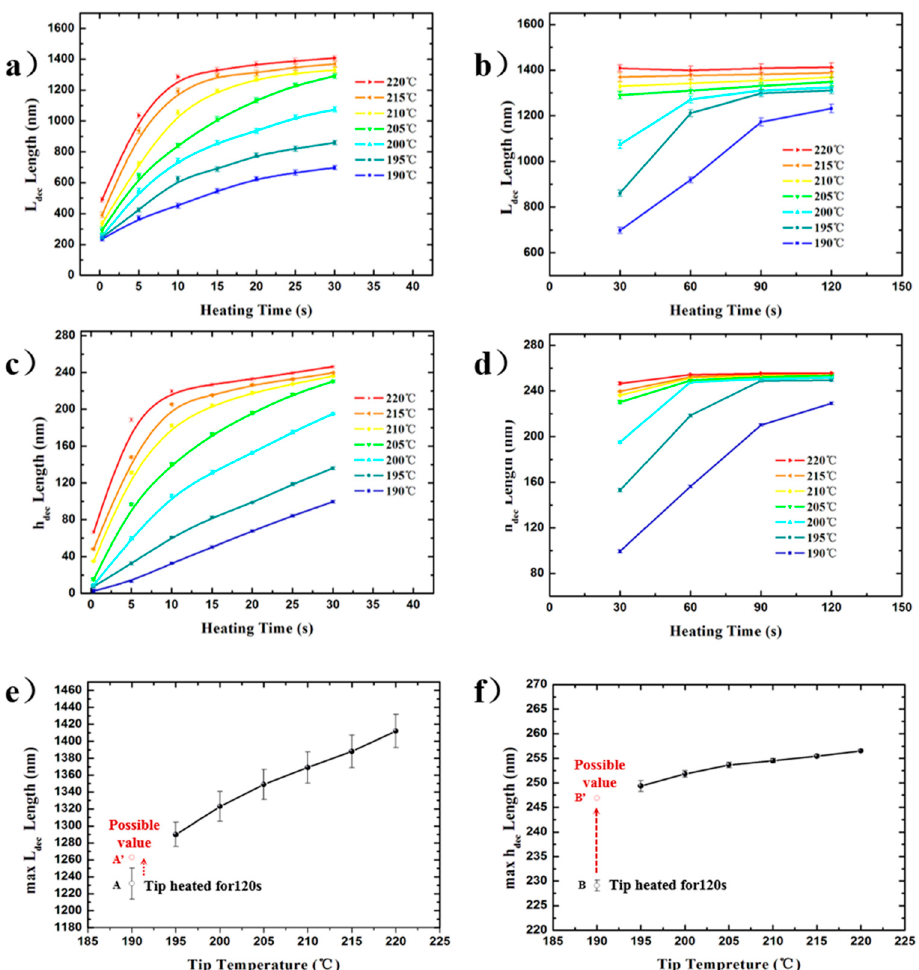
Figure 4. Function plot of the air gap feature sizes increasing with heating duration at the preset tip temperatures ( T t ) and the maximum feature sizes increasing with preset tip temperatures. ( a ) / ( b ) and ( c ) / ( d ) for L dec and h dec with 0.3–30 s / 30–120 s as the varying of heating duration, respectively, at T t of 190–220 ◦ C. ( e ) and ( f ) for the max L dec and max h dec with a T t of 190–220 ◦